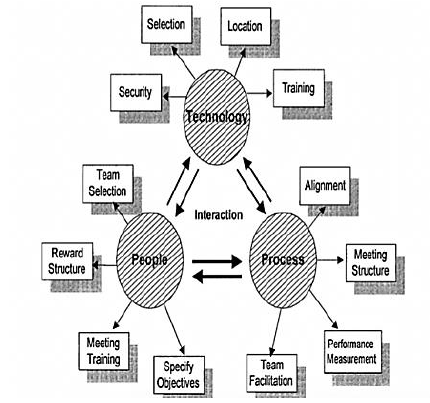
Figure 1 . Factors contributing to effective team working